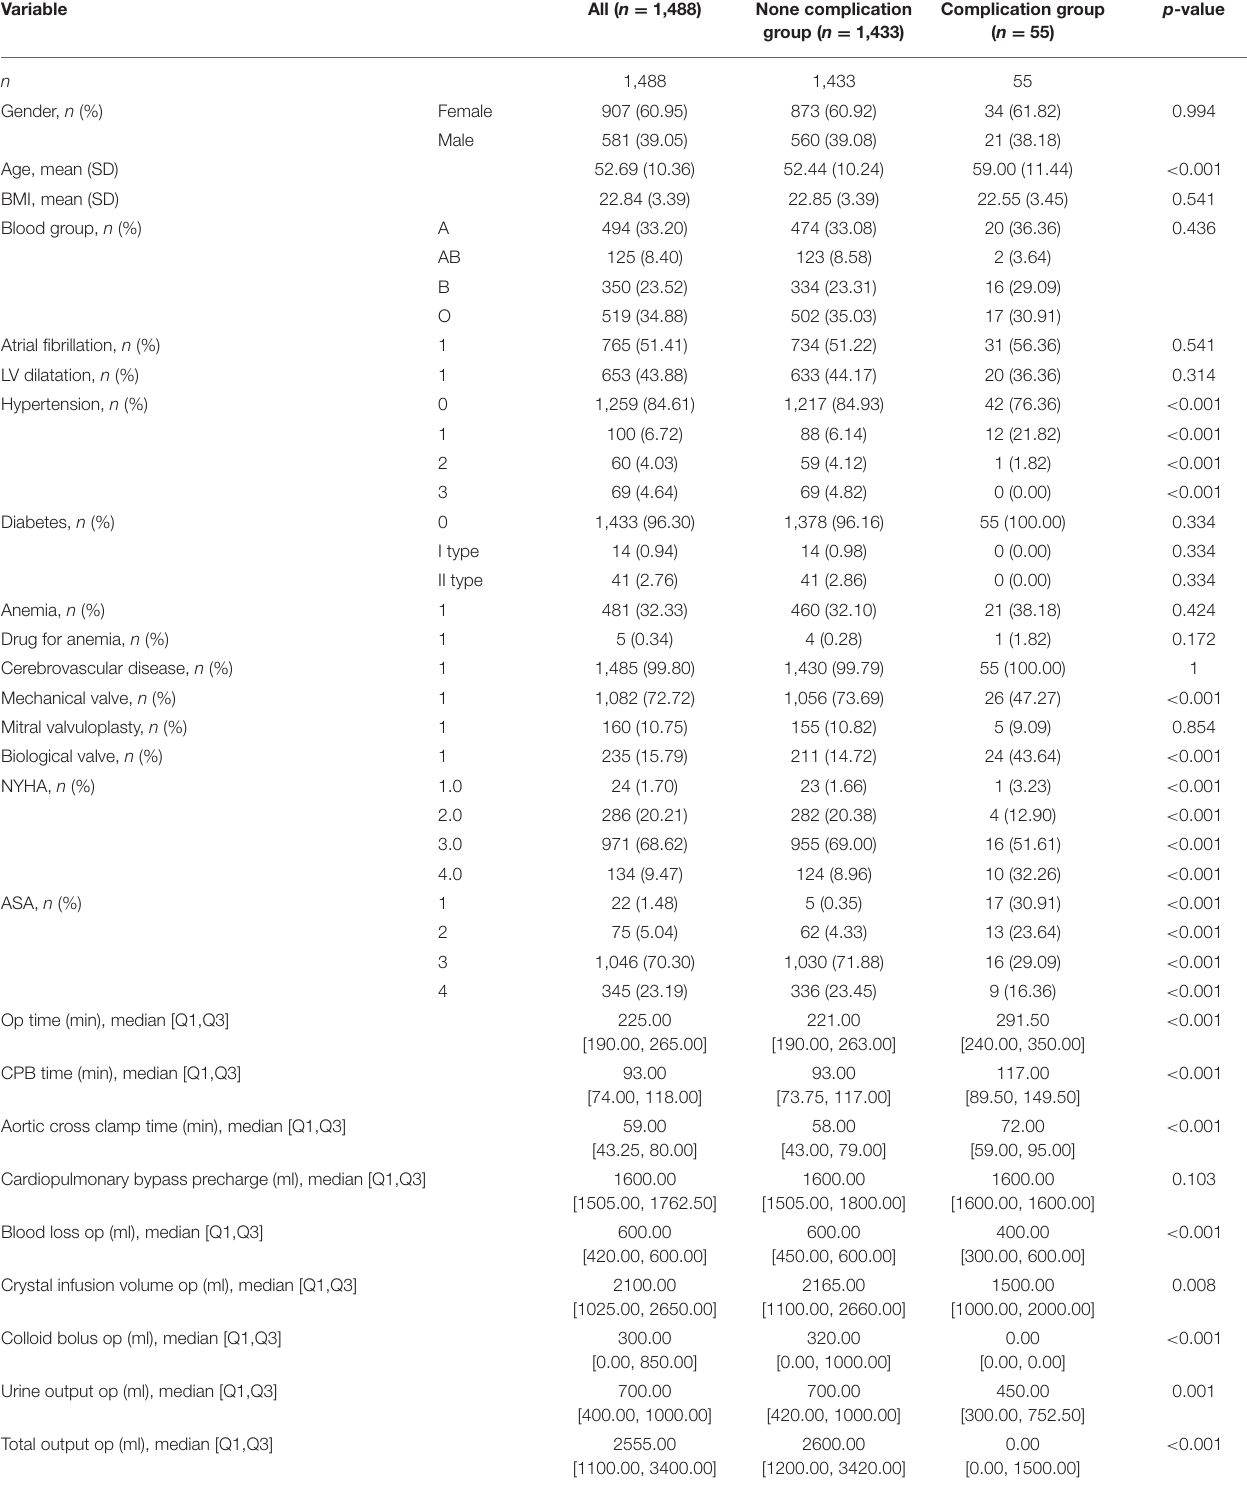
TABLE 1 | Preoperation and intraoperative